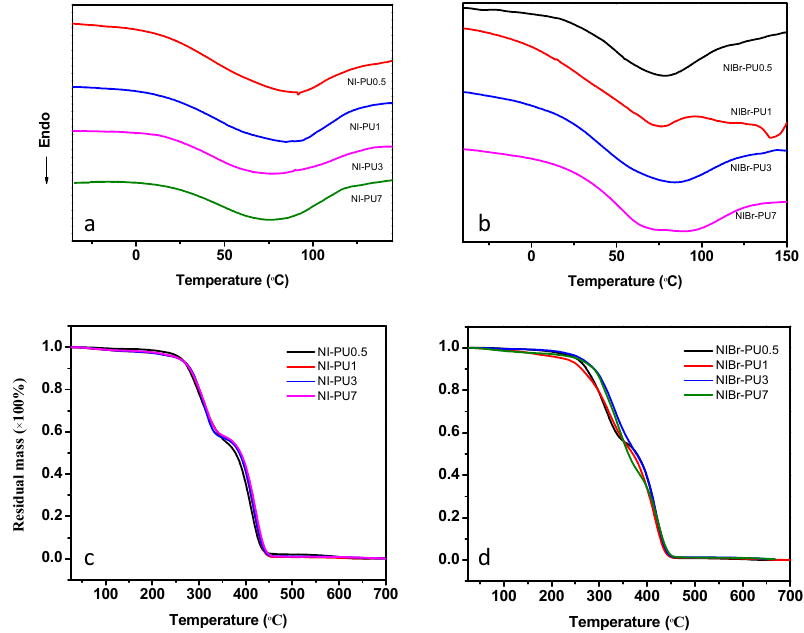
Figure 2. DSC curves for NI-PU ( a ) and NIBr-PU ( b ). TG analysis spectra of NI-PU ( c ) and NIBr-PU ( d ).